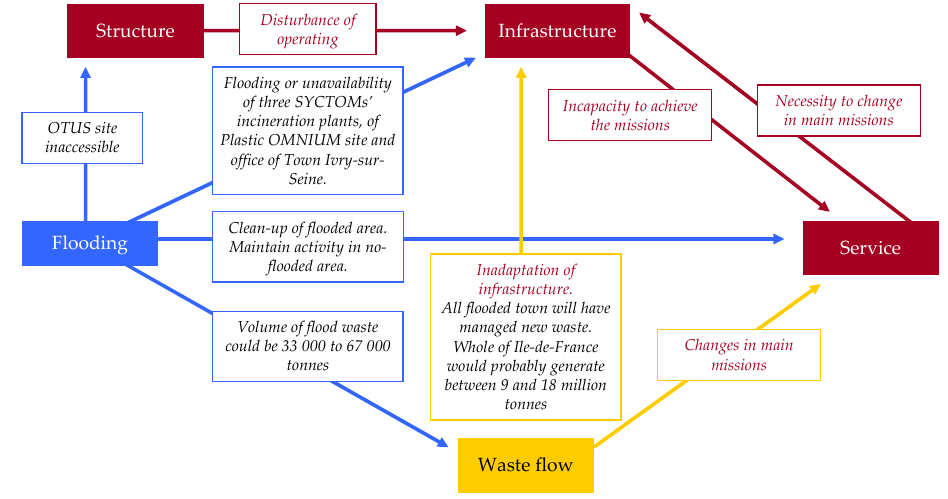
Fig. 10. Consequences of flooding on Ivry’s waste management Fig. 10 : Consequences of flooding on Ivry’s waste management system 10